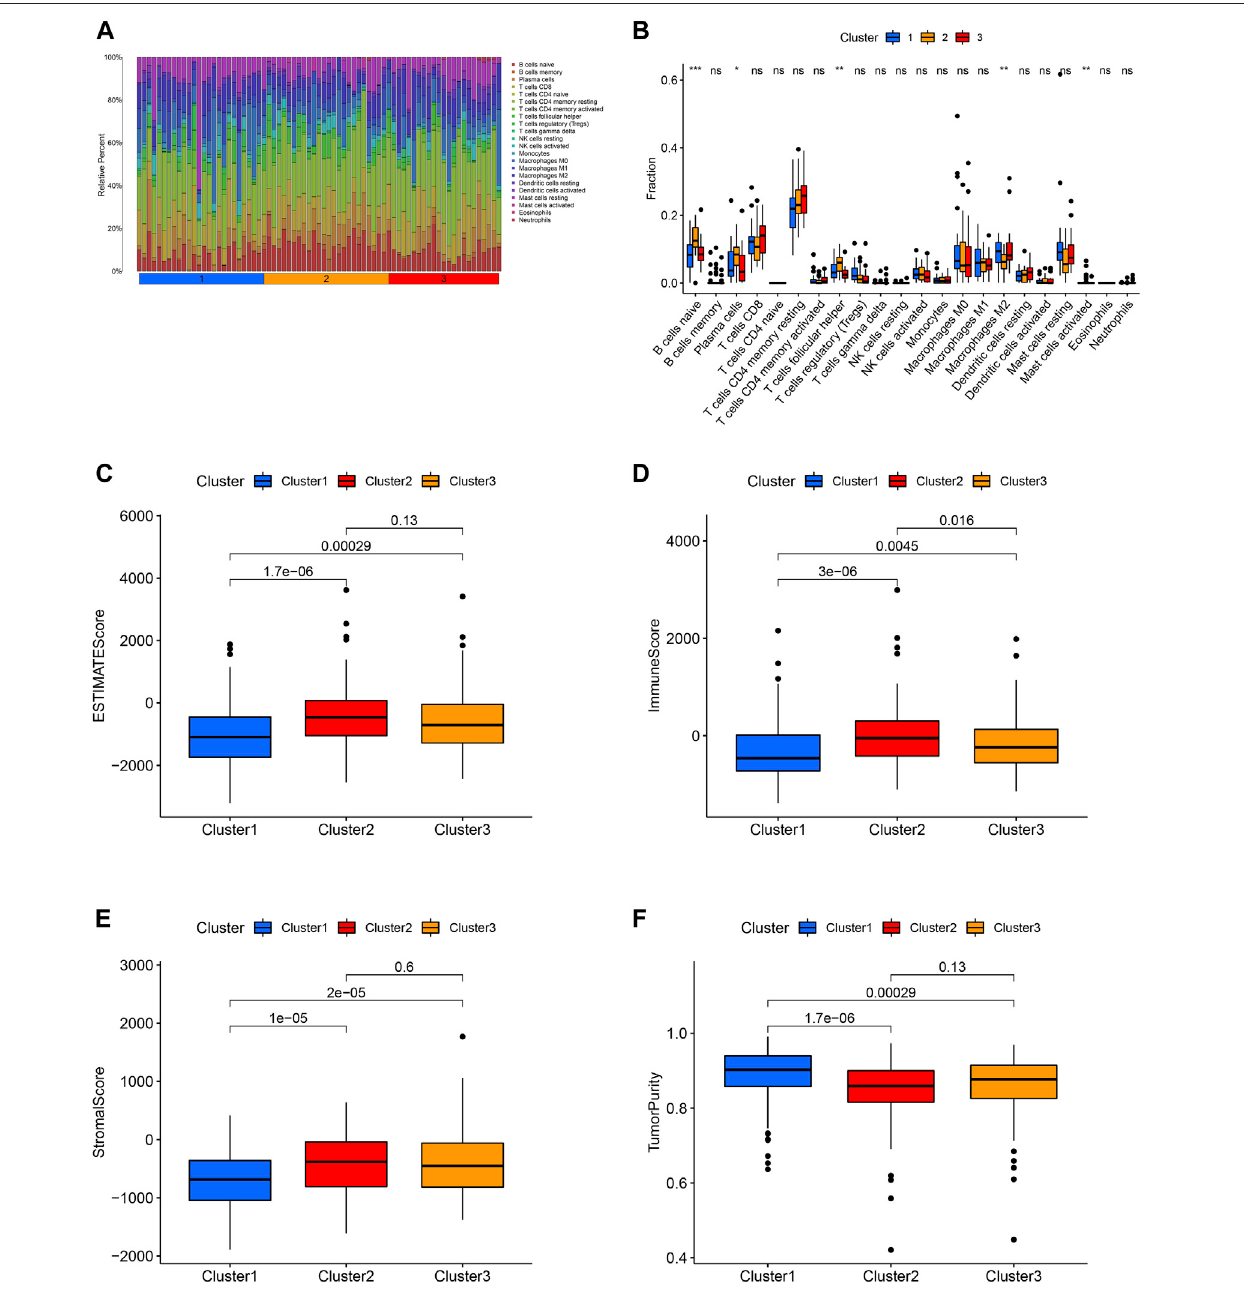
FIGURE 4 | Distribution of22 immune cell among these three molecular clusters (A) . Relationship between this ferroptosis-related molecular clusters and immune cell in fi ltration (B) . Relationship between the ferroptosis-related molecular clusters and ESTIMATE score (C) , immune score (D) , stromal score (E) , tumor purity (F) of tumor